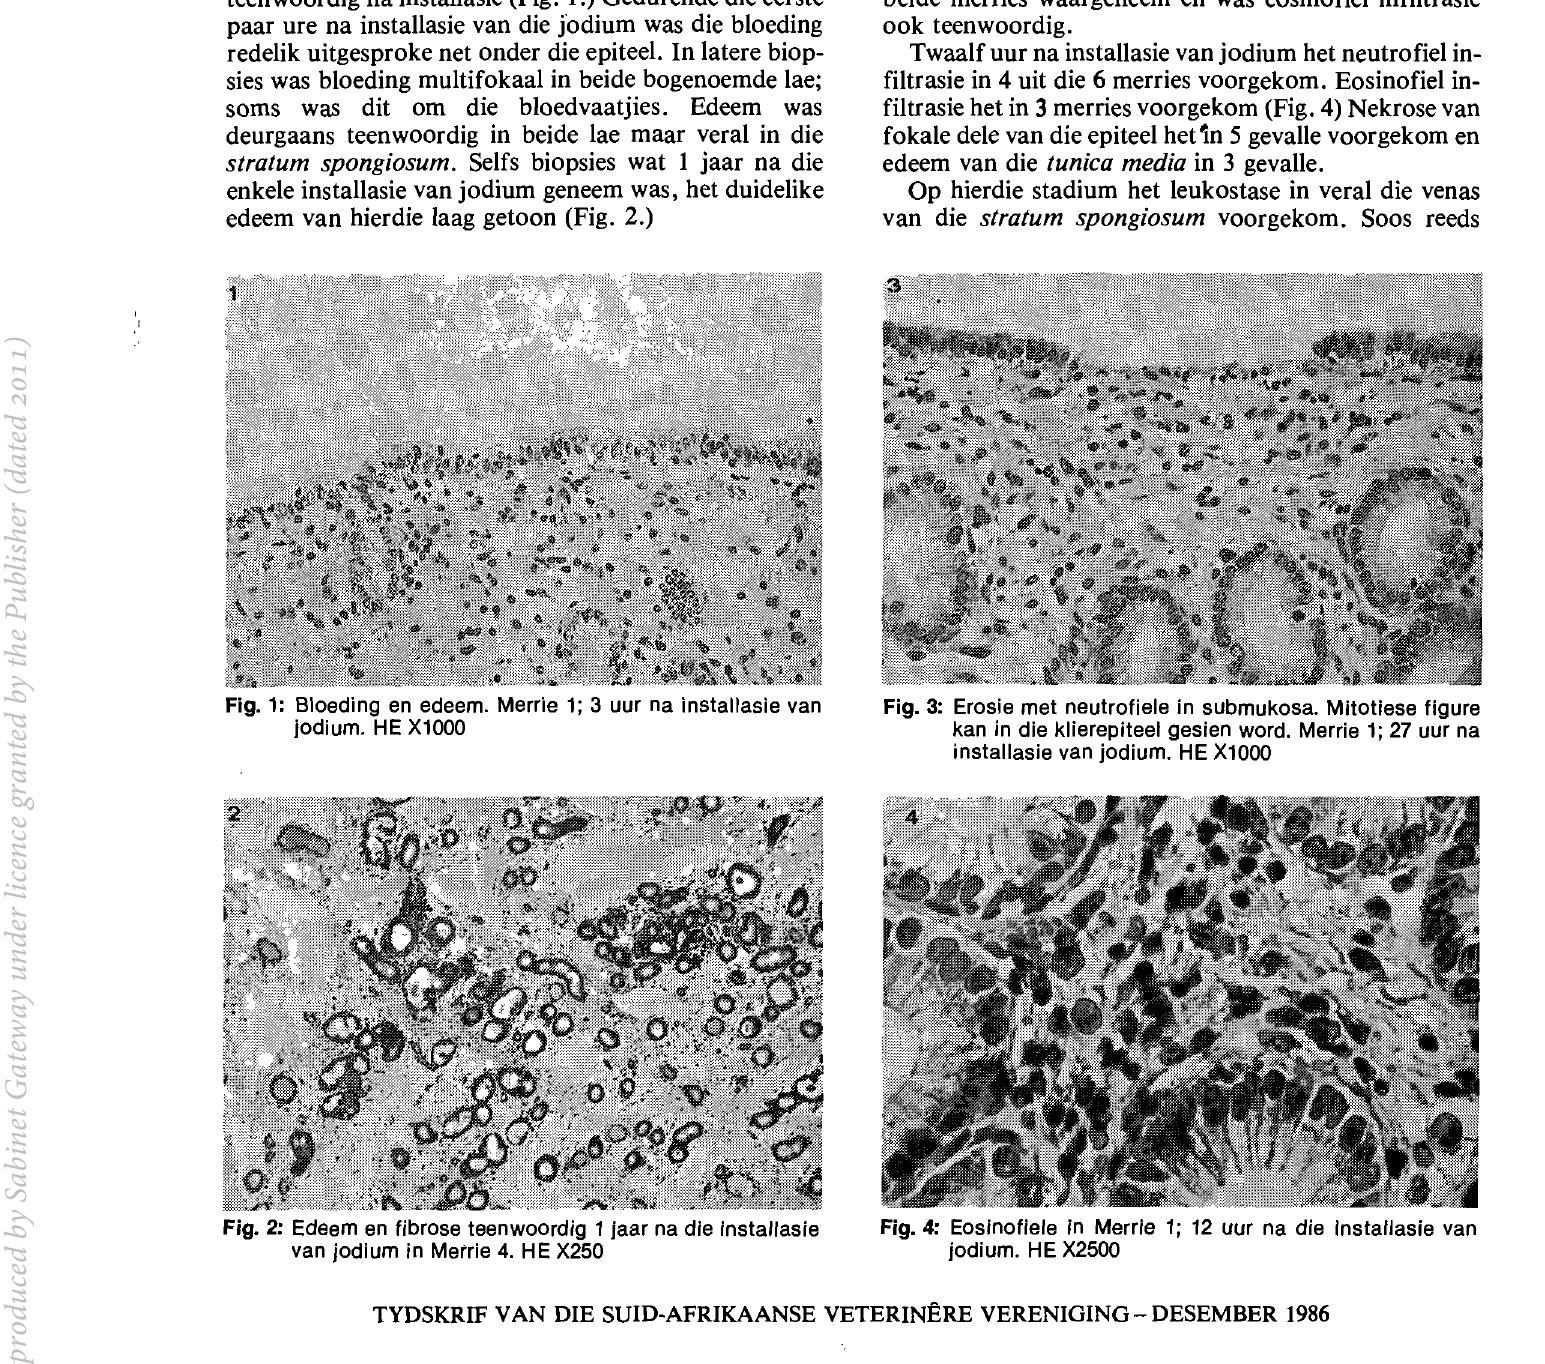
Fig. 4: Eosinofiele in Merrie 1; 12 uur na die Instal/asie van Fig. 2: Edeem en fibrose teenwoordig 1 jaar na die instal/asie jodium. HE X2500 van jodium in Merrie 4. HE X250 TYDSKRIF VAN DIE SUID-AFRlKAANSE VETERINERE VERENIGING-DESEMBER